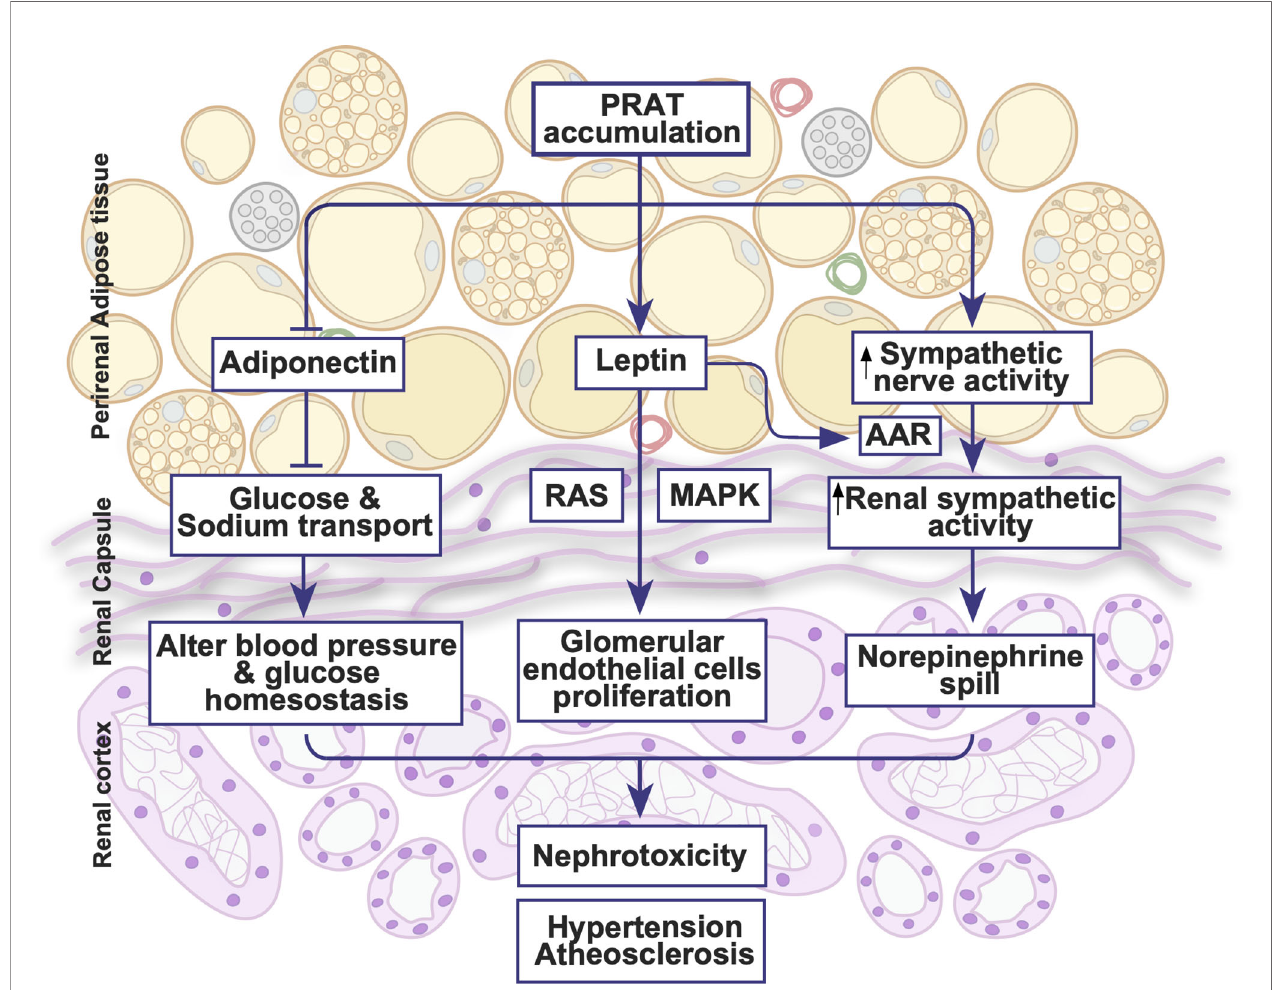
FIGURE 1 | Illustrative summary of perirenal adipose tissue physiology. PRAT exhibits an extensive blood supply, lymphatic channels and neuronal innervations. PRAT accumulation activates sympathetic activity, leptin secretion and renin angiotensin system all of which could lead to hypertension, atherosclerosis and nephrotoxicity. AAR, adipose afferent re fl ex; MAPK, mitogen-activated protein kinase; RAS, renin angiotensin